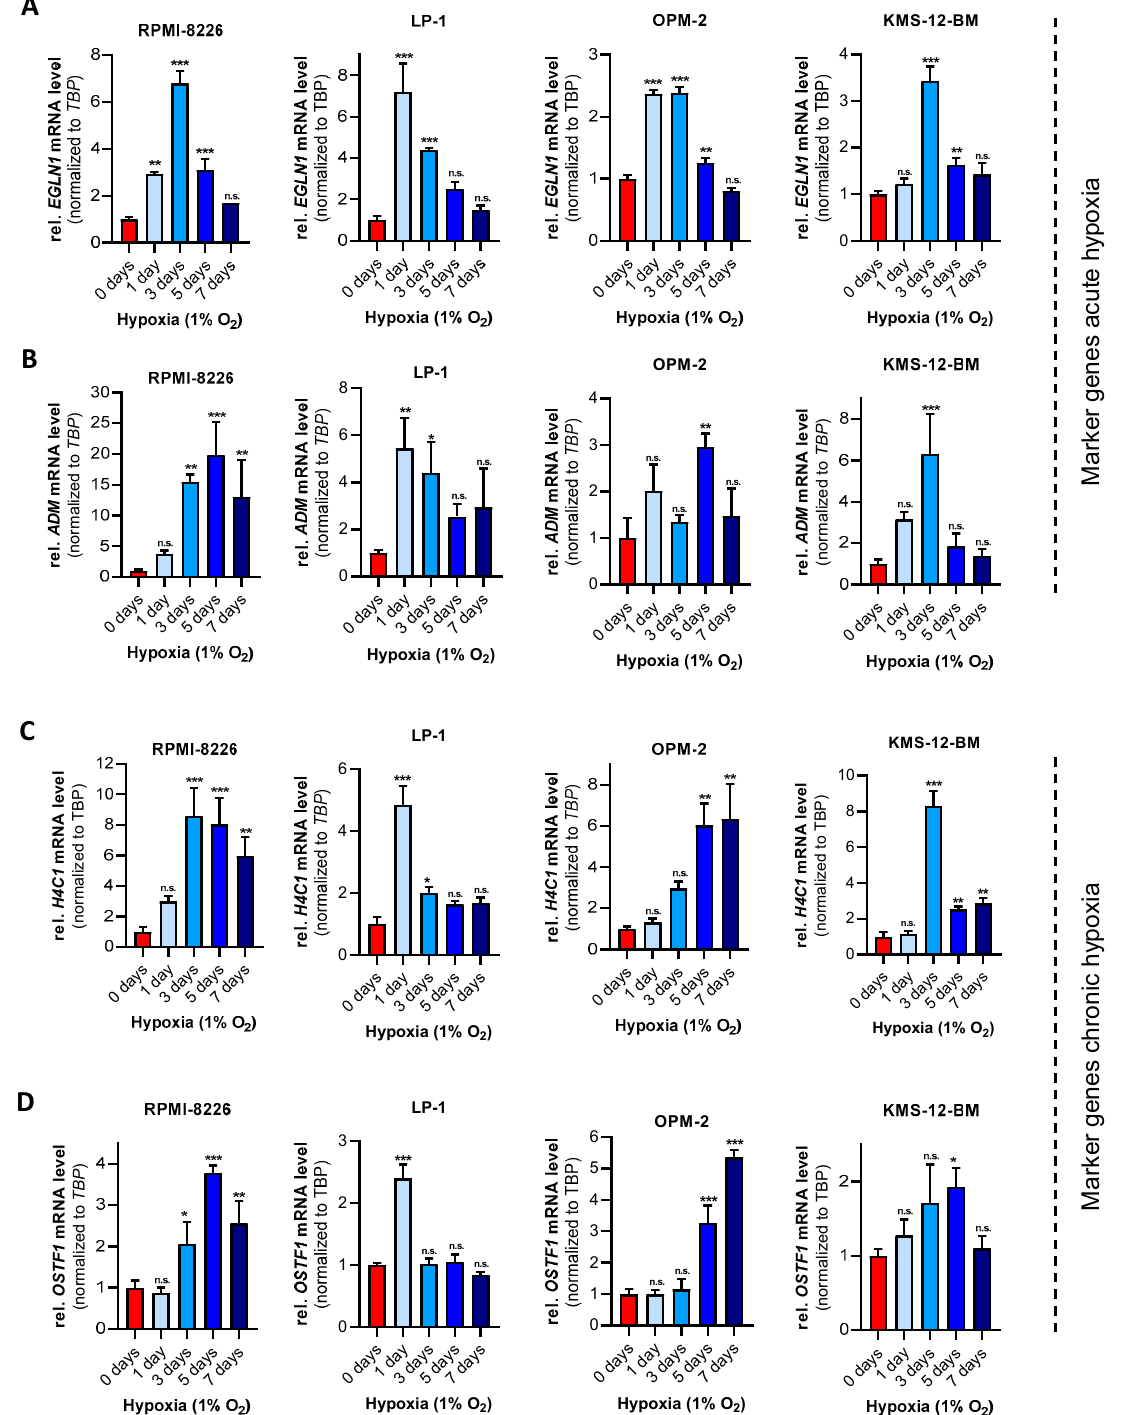
Figure 1. Definition of chronic hypoxia in MM cells: mRNA expression of acute and chronic hypoxia-related marker genes in RPMI-8226, LP-1, OPM-2 and KMS-12-BM cells grown at 1% O 2 for 0, 1, 3, 5 and 7 days. ( A ) relative EGLN1 mRNA levels normalized to TATA-box-binding protein ( TBP ) and to day 0. ( B ) relative ADM mRNA levels normalized to TBP and day 0. ( C ) relative H4C1 mRNA levels normalized to TBP and day 0. ( D ) relative OSTF1 mRNA levels normalized to TBP and day 0. Graphs indicate mRNA levels ± SD of one representative experiment, total n = 3. One-way ANOVA with Bonferroni’s multiple comparison test. * p < 0.05; ** p < 0.01, *** p < 0.001. Values of p > 0.05 were considered not significant